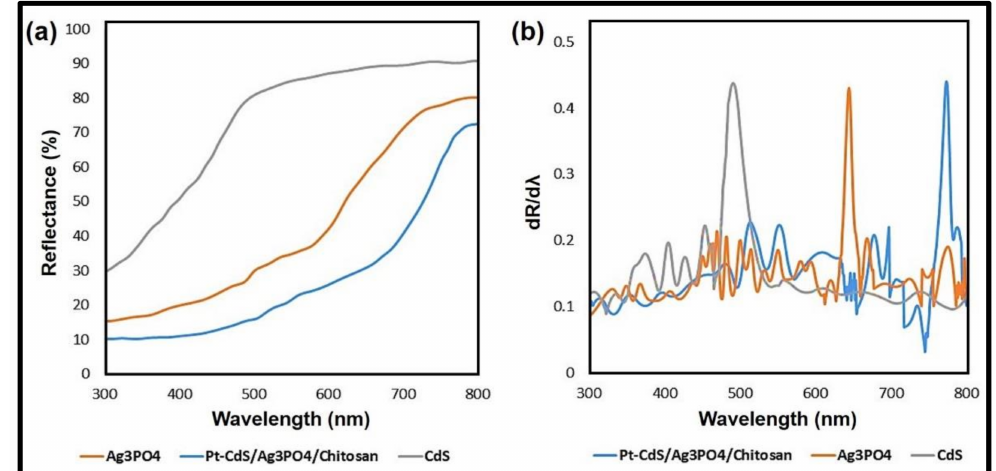
Figure 3. ( a ) The UV–vis di ff use reflectance spectra (DRS) of CdS, Ag 3 PO 4 , and Pt-Ag 3 PO 4 / CdS / chitosan; ( b ) the corresponding first derivative